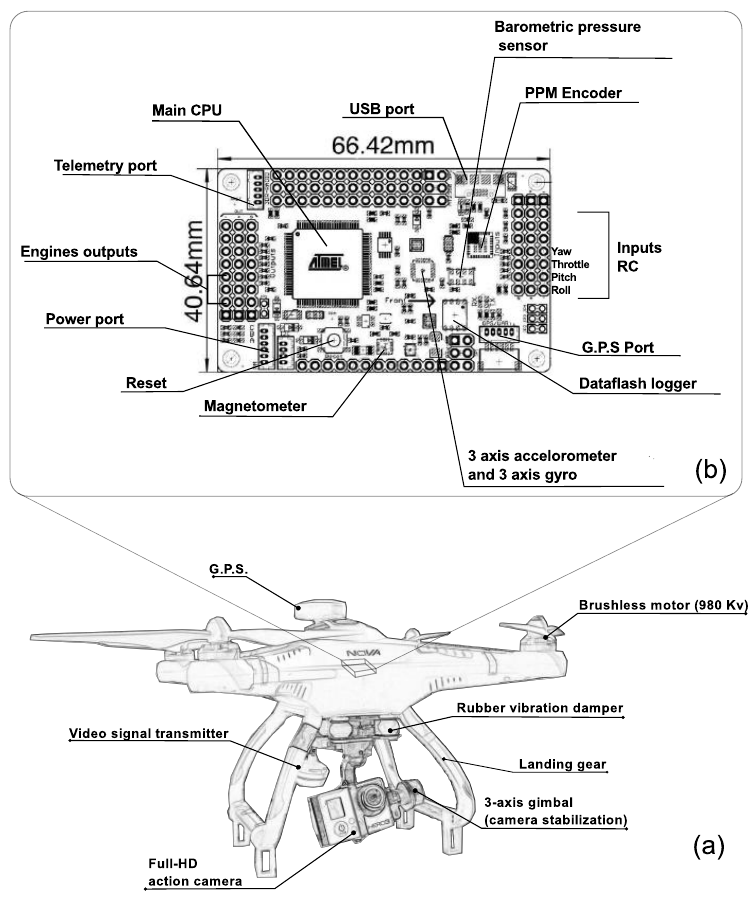
Figure 2. The modified lightweight quadcopter used in this study ( a ) and a schematic representation; ( b ) of the integrated navigation and autopilot systems (APM